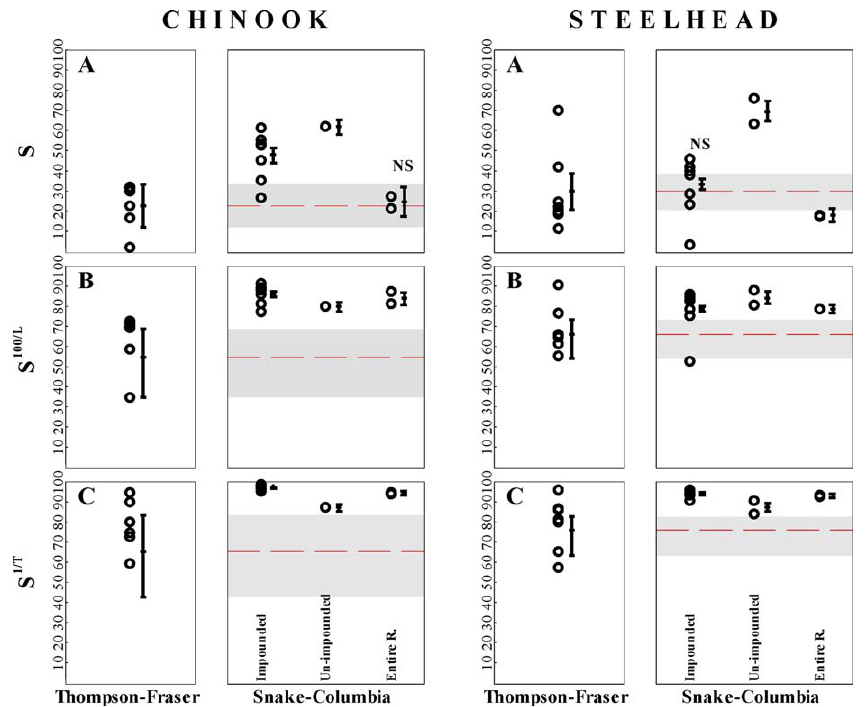
Figure 3. Annual Survival Estimates (%) for Thompson and Snake River Spring Chinook and Steelhead (A) Estimated survival. (B) Survival scaled per 100 kilometers traveled, S 100/ L . (C) Survival scaled per migration day, S 1/ T . For each species, the left panel shows the survival of different Thompson River stocks released to migrate down to the Fraser River mouth; the right panel shows the survival of Snake River stocks migrating down three sections of the Columbia River hydropower system: Impounded (upper river; eight dams), Unimpounded (lower river; undammed), and Entire river. The cross to the right of each group of individual survival estimates (open circles) shows the average survival and 95% confidence interval for the group, averaged across all available data (see Text S3 for details). For ease of comparison, the average Fraser River survival and 95% confidence limits are also drawn as a band across the Columbia River results. For Snake River stocks, impounded refers to survival measured using PIT tags from the Snake River trap to the last (Bonneville) dam (see Table 1). Unimpounded refers to survival measured from Bonneville Dam to near the river mouth (Astoria) using acoustic tags. The Chinook survival value for ‘‘ Entire River ’’ is based on the 2006 study using acoustically tagged Dworshak Hatchery smolts (tagged and released at Kooskia National Fish Hatchery) and whose survival was measured at an ocean listening line at Willapa Bay, 920 km distant. A single whole-river estimate is not available for steelhead, but a synthetic value can be obtained for 2002 and 2003 by multiplying up-river PIT tag survival by lower river acoustic tag survival, and scaling by total travel distance or time as appropriate. A similar combined estimate of survival for Chinook can be calculated from the 2004 data, and is also shown for comparison. In all comparisons of average river survival, Snake-Columbia River estimates were significantly different than Thompson-Fraser estimates at the 95% level unless indicated by ‘‘ NS.